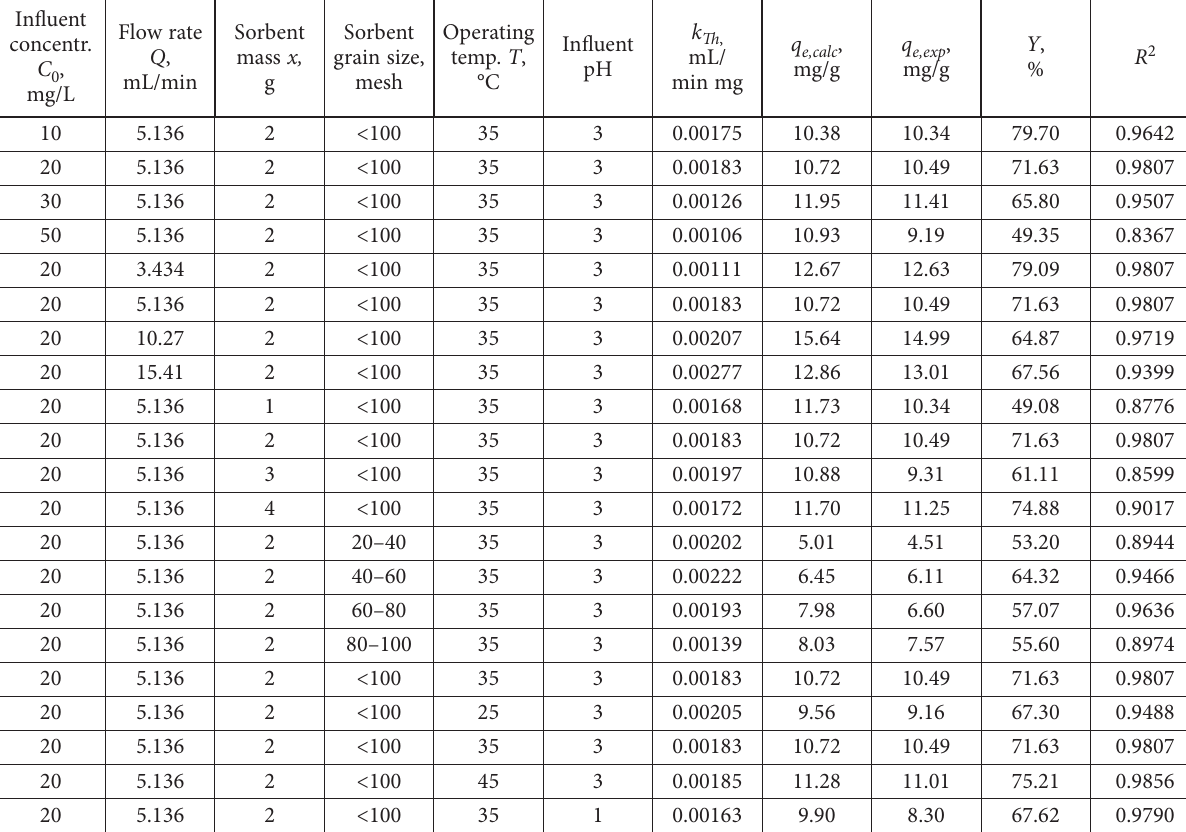
Table 1. Parameters of the Thomas model using linear regression analysis and the equilibrium As(V) uptake (q e ) and the total removal percentage (Y) for As(V) sorption to PC-Fe/C under different conditions Influent